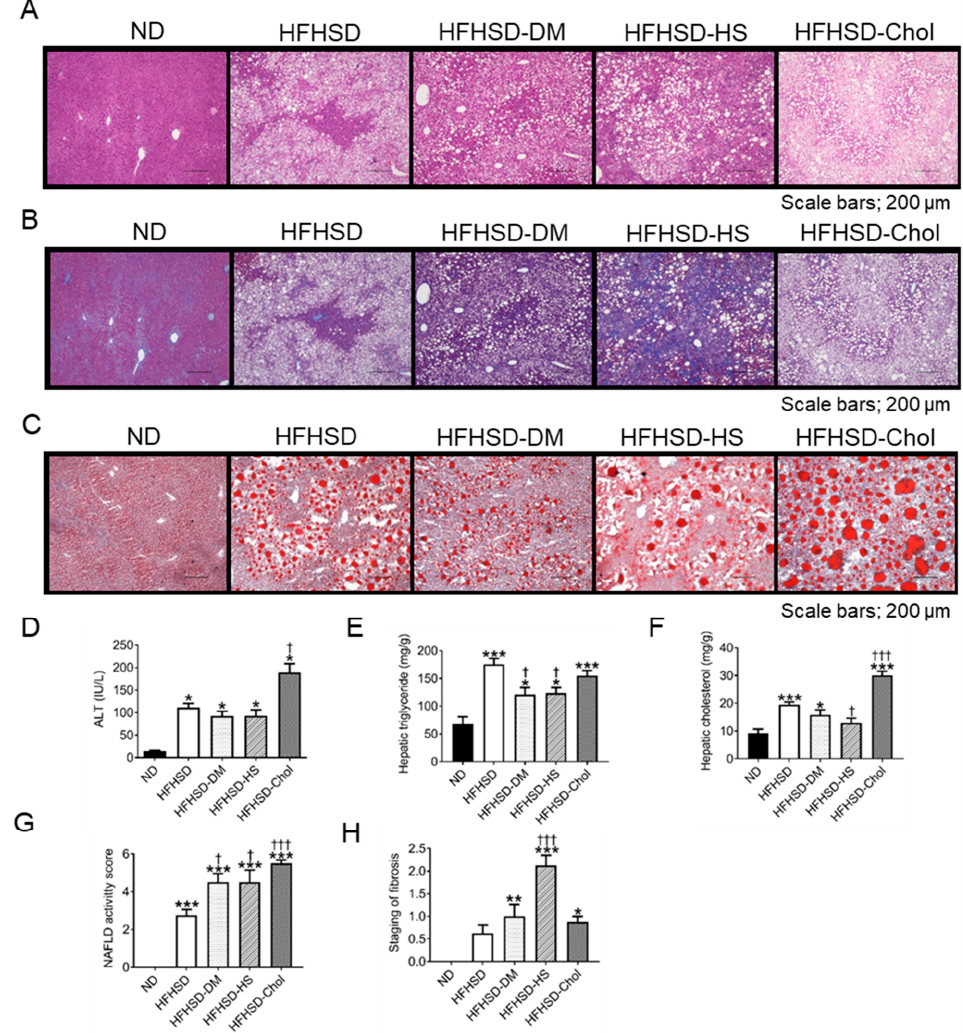
Figure 2. HFHSD-SH showed the worst steatohepatitis and HFHSD-Chol showed the worsened 223 steatohepatitis. (A) Hematoxylin and eosin staining of liver for ND, HFHSD, HFHSD-DM, HFHSD- 224 SH, HFHSD-Chol. Scale bars, 200 µm. (B) Masson trichrome staining of liver for liver for ND, 225 HFHSD, HFHSD-DM, HFHSD-SH, HFHSD-Chol. Scale bars, 200 µm. (C) Oil red O staining of liver 226 for ND, HFHSD, HFHSD-DM, HFHSD-SH, HFHSD-Chol. Scale bars, 200 µm. (D) Serum ALT levels 227 (n = 12-16). (E, F) Hepatic cholesterol and triglyceride content (n = 8). (G,H) Non-alcoholic fatty liver 228 disease (NAFLD) activity score (n = 8) and staging of fibrosis (n = 8) were adapted from Brunt et al. 229 ND, normal diet group; HFHSD, high-fat/high-sucrose (HFHSD) diet group; HFHSD-DM, HFHSD 230 group, which were received streptozocin (STZ) (50 mg/kg/day for 2 days on the age of 20 weeks); 231 HFHSD-SH, choline deficient HFHSD group; HFHSD-Chol, 1% cholesterol and 0.1% deoxycholic 232 acid containing HFHSD group; ALT, alanine aminotransferase; NAFLD, non-alcoholic fatty liver 233 disease. Error bars represent SEM. *p < 0.05, **p < 0.01, ***p < 0.001 compared to ND and †p < 0.05, 234 ††p < 0.01, †††p < 0.001 compared to HFHSD. 235